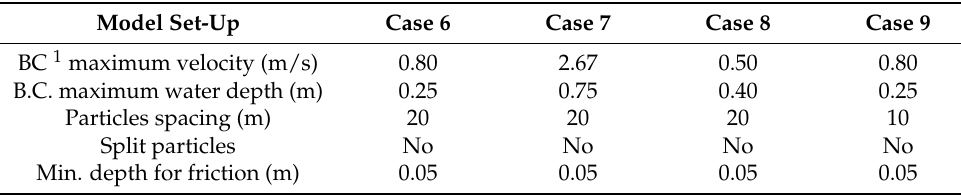
Figure 3. Filling of floodplain depressions case: ( a ) DEM map showing the location of the upstream boundary condition (red line upper left corner) and ground elevation contour lines every 0.05 m; ( b ) inflow hydrograph on the left upper corner of the domain. Table 4. Filling of floodplain depressions test cases.